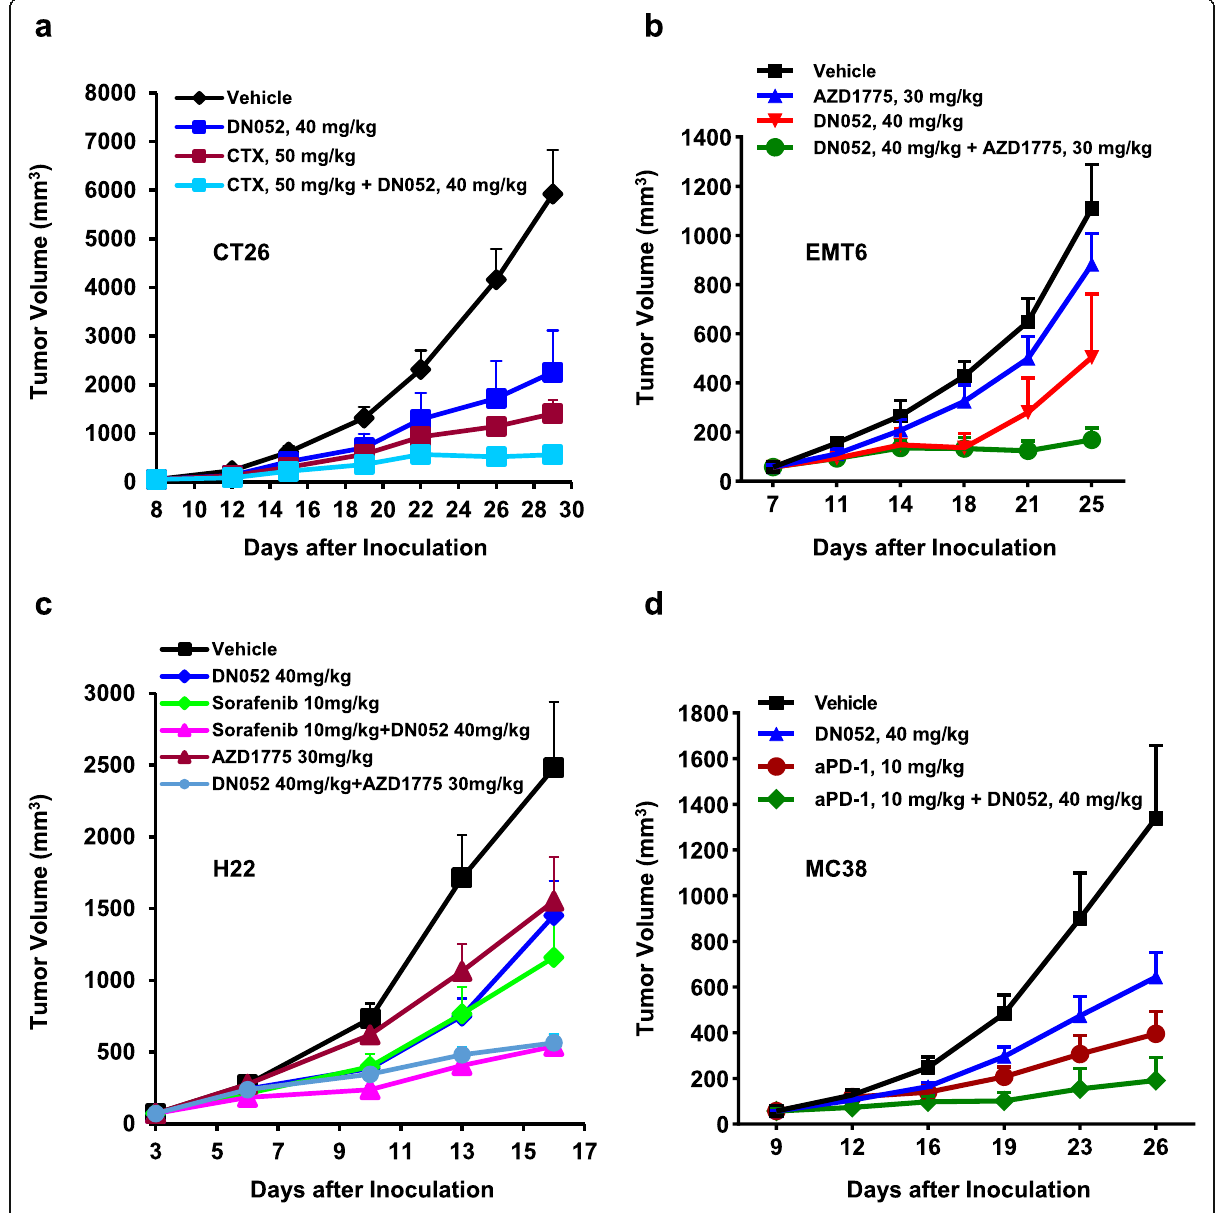
cancer model ( a ), EMT6 breast cancer model ( b ), H22 liver cancer model ( c ) and MC38 colon cancer model ( d